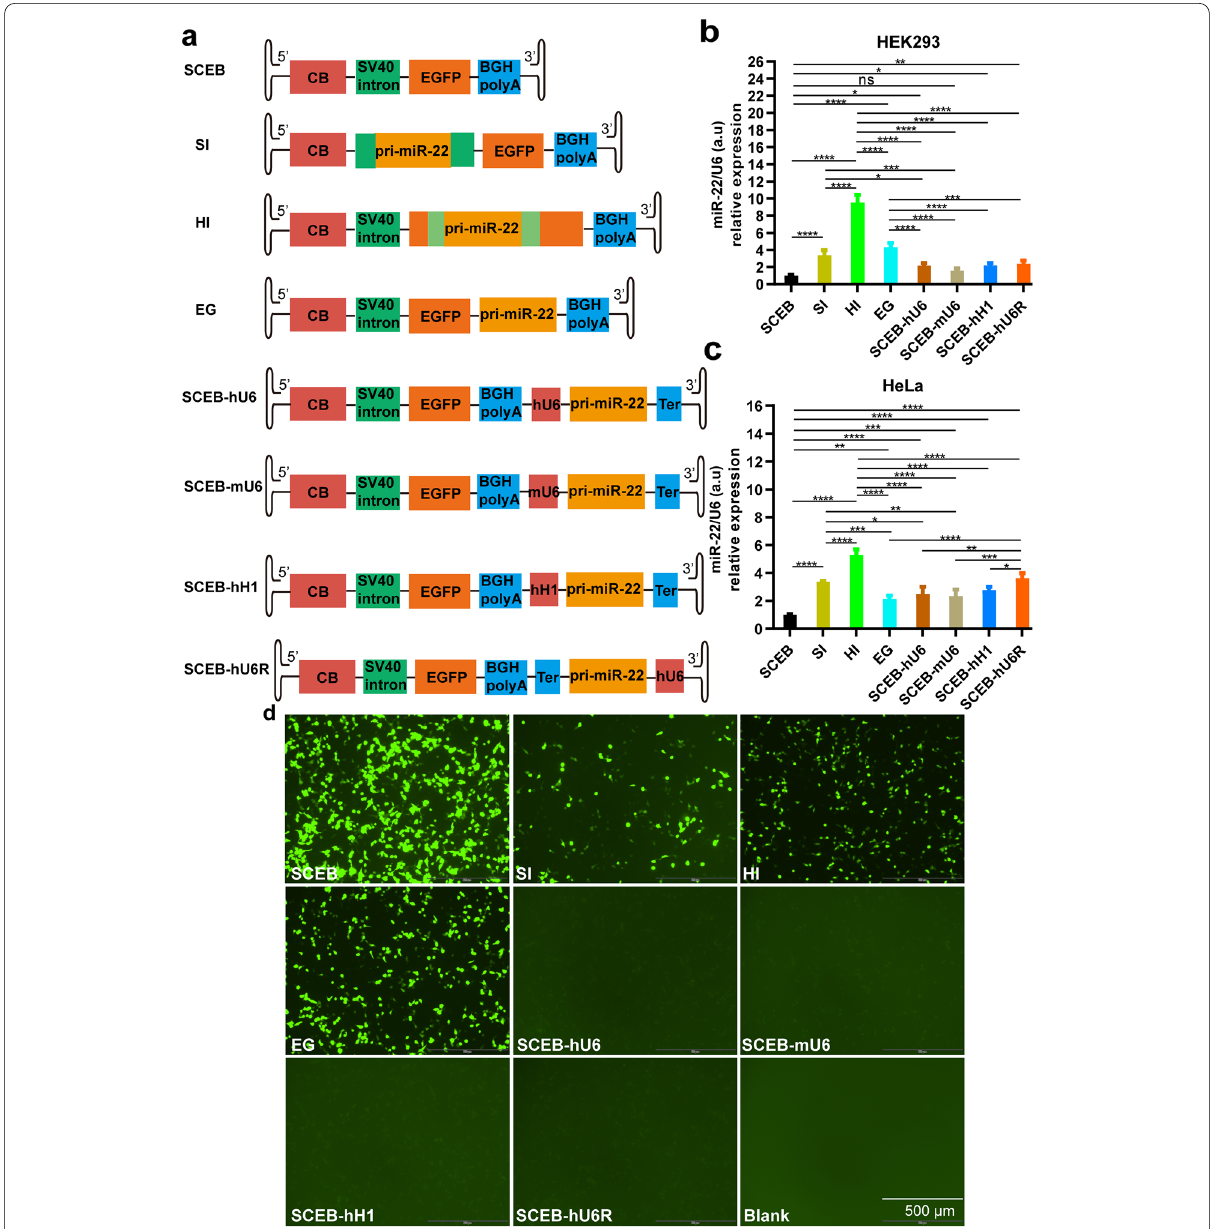
Fig. 4 miR-22 expression comparisons dependent on or independent of EGFP expression cassettes. a Schematic pictures of miR-22 and EGFP expression cassettes in rAAV vector plasmids. CB, chicken β-actin promoter with CMV enhancer; hH1, human H1 promoter; Ter, TTT TTT sequence, the termination signal for miRs. Two boxes in light green on both sides of pri-miR-22 in HI vector indicated separate parts of another intron named hCG intron from hCG gene. b miR-22 expression levels in HEK293 cells. c miR-22 expression levels in HeLa cells. d EGFP expression in HEK293 cells. n 4, error bars represent the standard deviation of the mean. * P < 0.05, ** P < 0.01, *** P < 0.001, and **** P < =